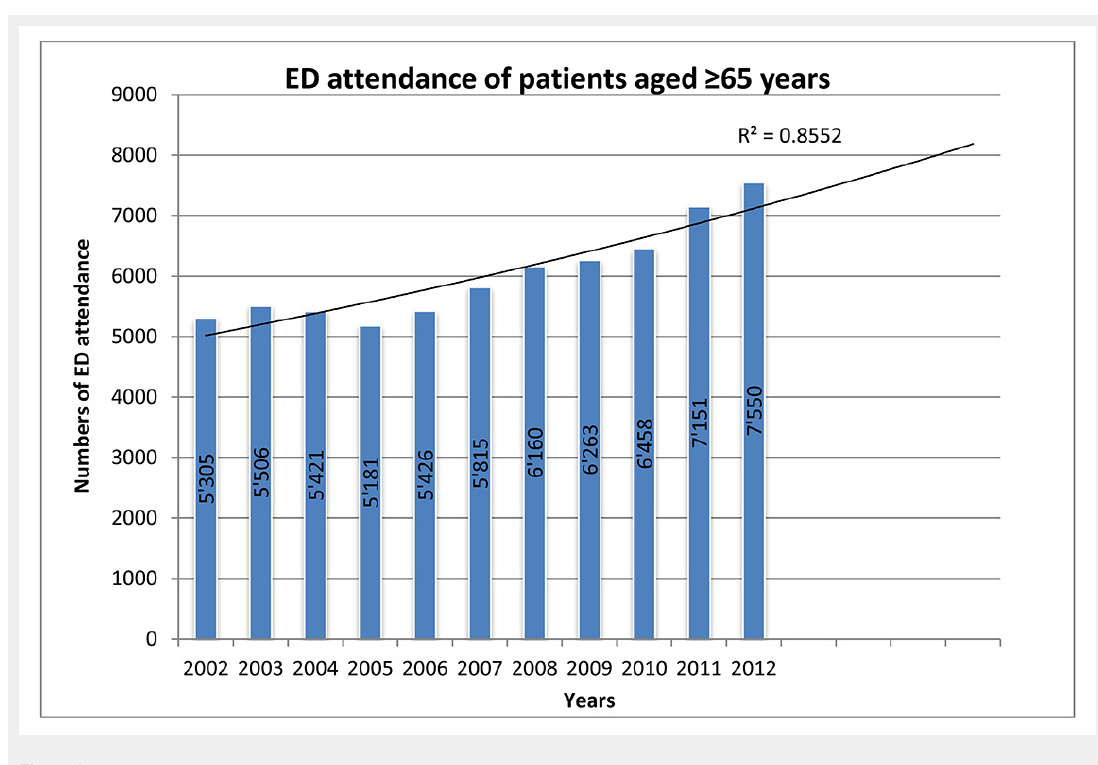
Figure 2 Trend of emergency department (ED) visits by patients aged 65 years and over. The development of the ED attendance of patients ≥65 years between 2002 and 2012 is provided. The line represents the trend of an exponential regression with the calculated coefficient R 2 = 0.8552 of the ED attendance of this patient group based on the existing data. It is probable that the patients ≥65 years will continue to